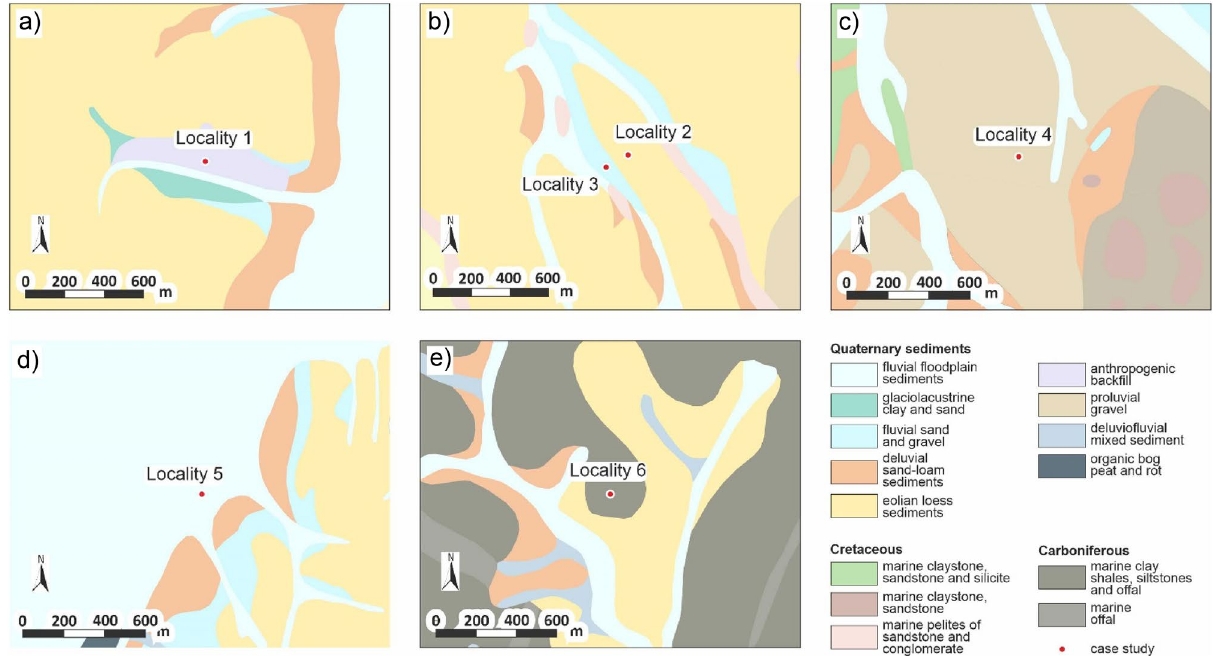
Figure 2. Location of case studies in the geological map ( a ) locality 1, ( b ) localities 2 and 3, ( c ) locality 4, ( d ) locality 5, ( e ) locality 6. Schematic figures made by the authors using CorelDRAW Graphic Suite 2019 software www. corel draw.